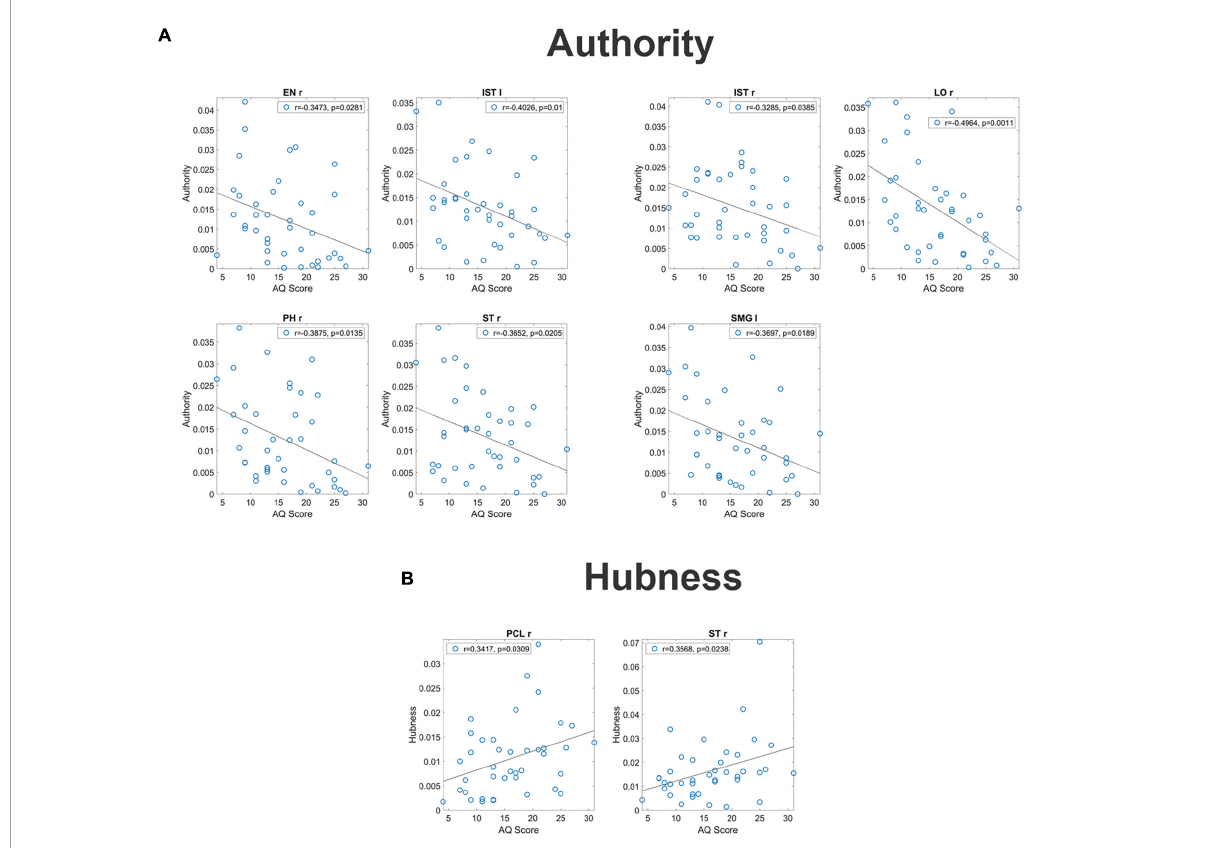
FIGURE2 Correlation between the authority and the AQ score [upper panel (A) ] and correlation between the hubness and the autistic score [bottom panel (B) ] for all ROIs which exhibit a significant p -value (uncorrected) for the correlation. These correlations have been computed on the complete normalized connectivity matrix. It is worth noting that the correlation is negative for the authority, denoting a more significant input flow in the Low AQ score Group, while correlation is positive for the hubness, denoting a more significant output flow for the High AQ score Group.